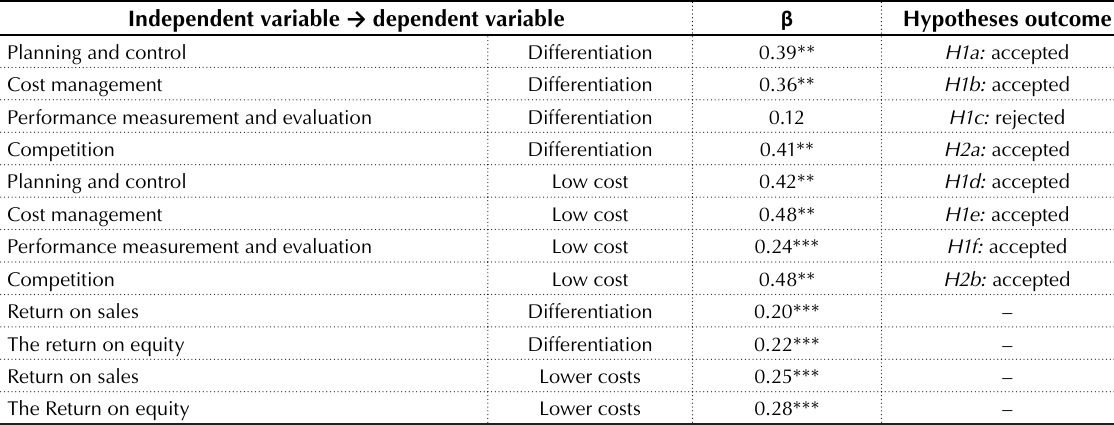
Table 4. Paths between sub-factors Independent variable → dependent